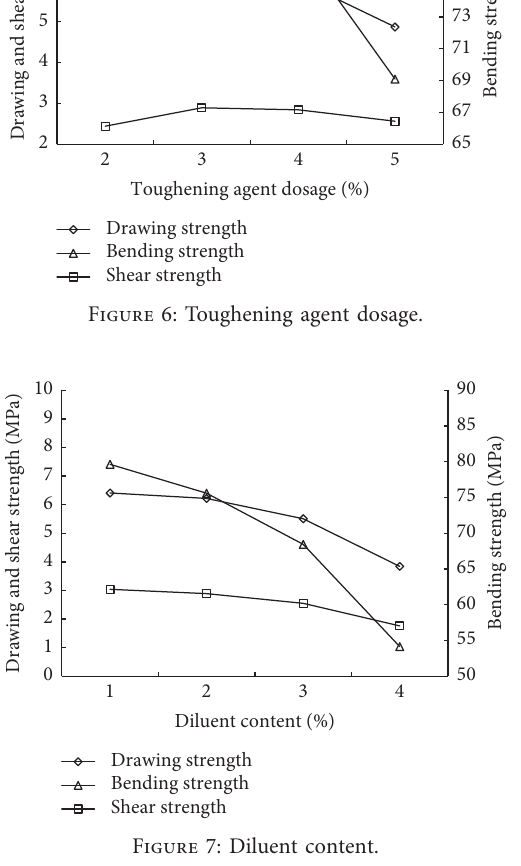
Figure 7: Diluent Table 4: Experimental factors and levels of the response surface. Factors